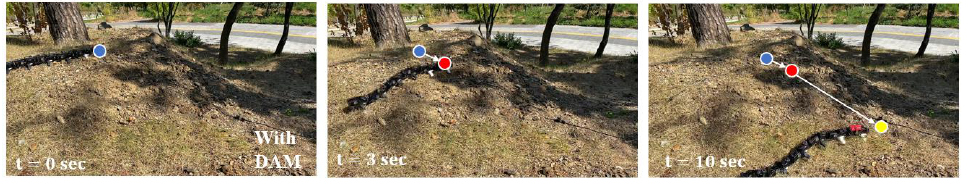
Figure 23. Performance of the descending motion without the DAM on the slope.